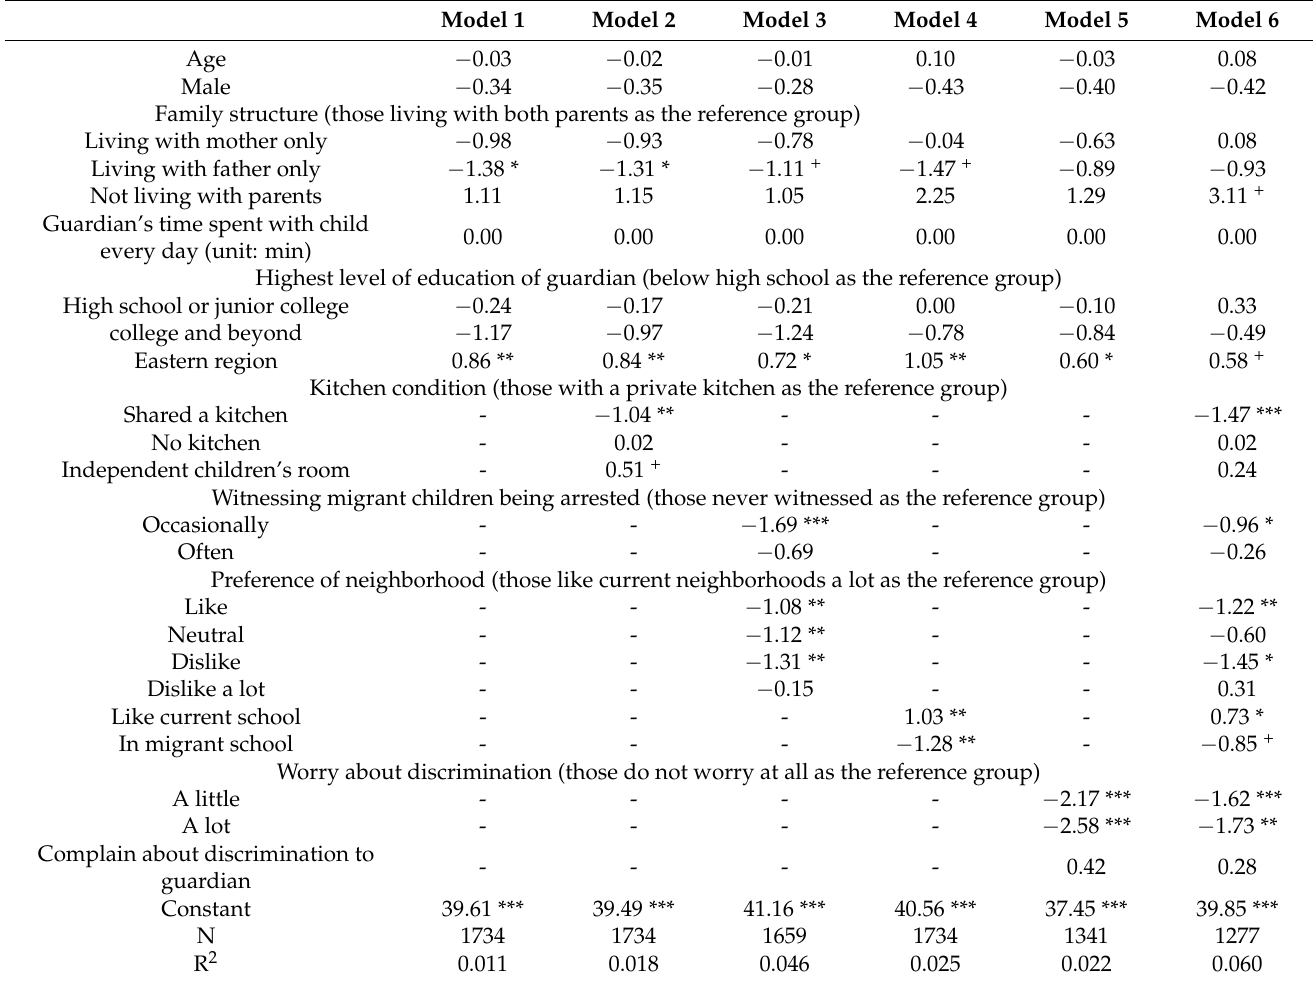
Table 2. OLS Regression Models Predicting Migrant Children’s Self-Esteem Score. Model 1 Model 2 Model